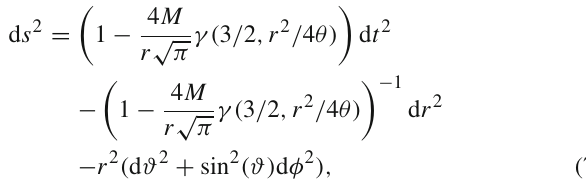
Fig. 1 Plot of − g tt = g − 1 rr as a function of r / √ √ θ . M = 1 . 0 θ ( black curve ) has no horizon, M = 1 . 9 M / curve ) has one degenerate horizon at r H = 3 . 0 ( red curve ) has two